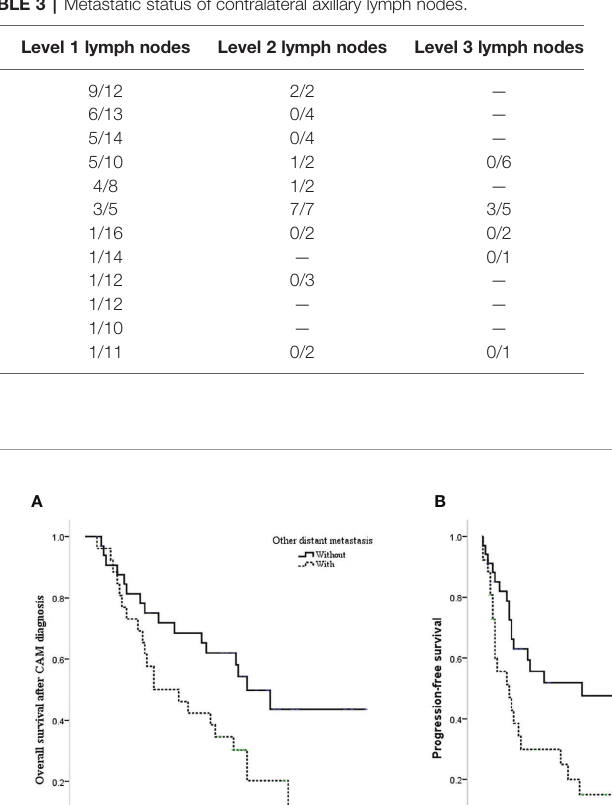
FIGURE 2 | Survival curves of CAM patients with or without other distant metastases. (A) CAM-OS of CAM patients with or without other distant metastases. (B) PFS of CAM patients with or without other distant metastases. (C) OS of CAM patients with or without other distant